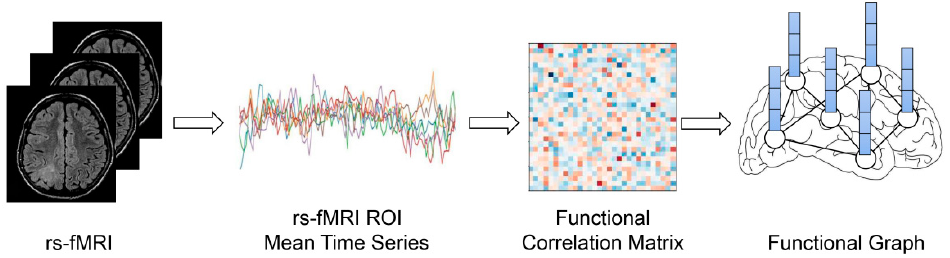
Figure 1. The schematic process of constructing brain FC matrix and functional graph input.